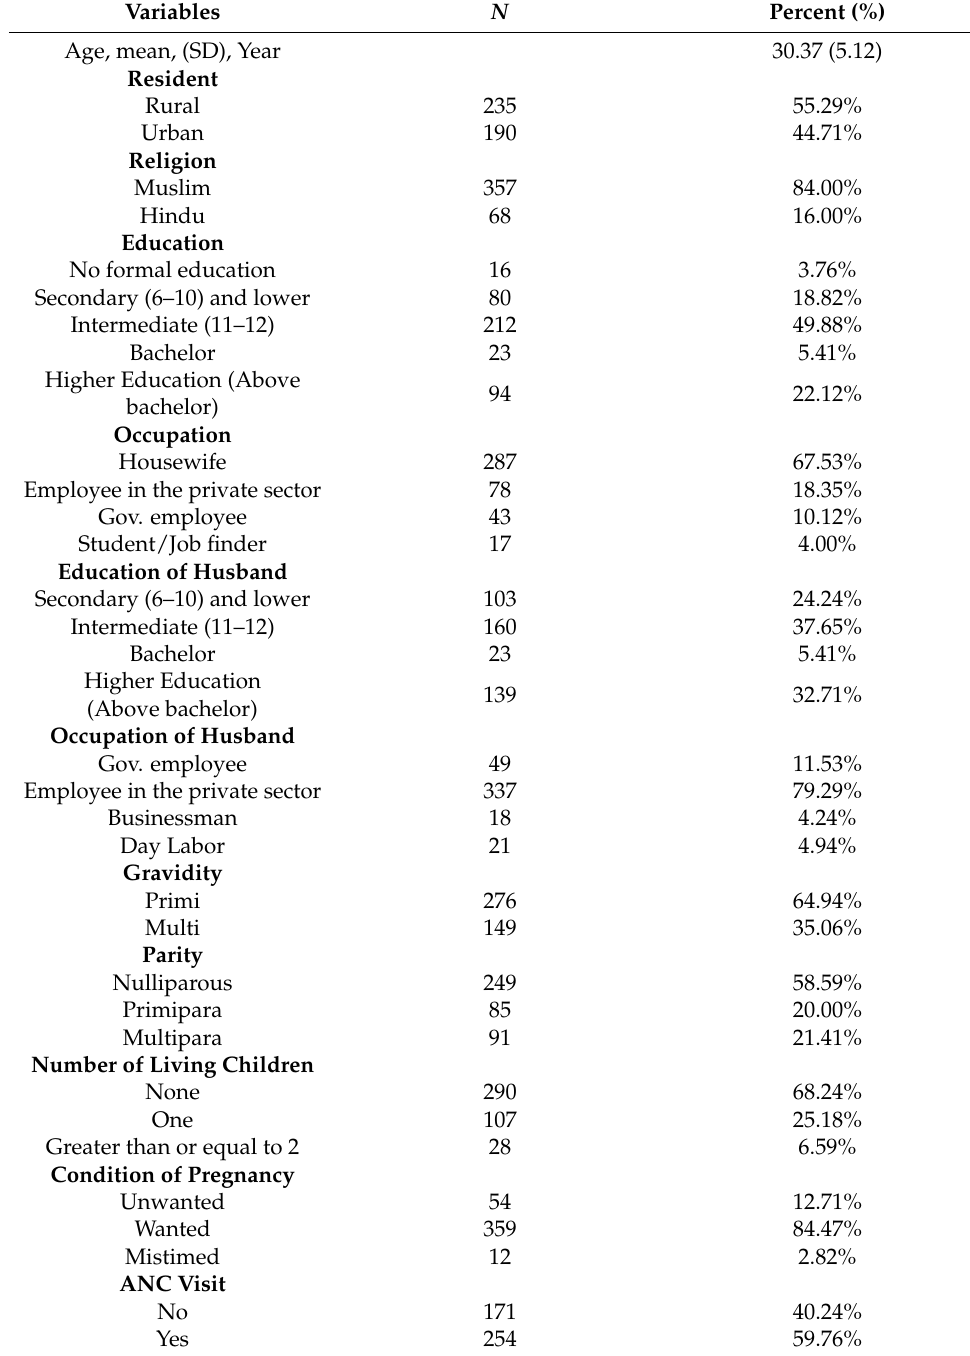
Table 1. Pregnant women’s distribution by socio-demographic, obstetric, and reproductive health- related characteristics ( n =